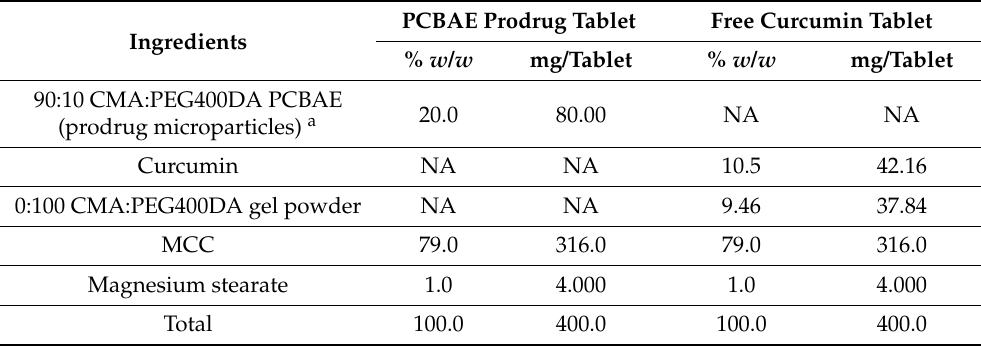
Table 1. Formulation table for poly(curcumin β -amino ester) (PCBAE) prodrug tablet and free curcumin